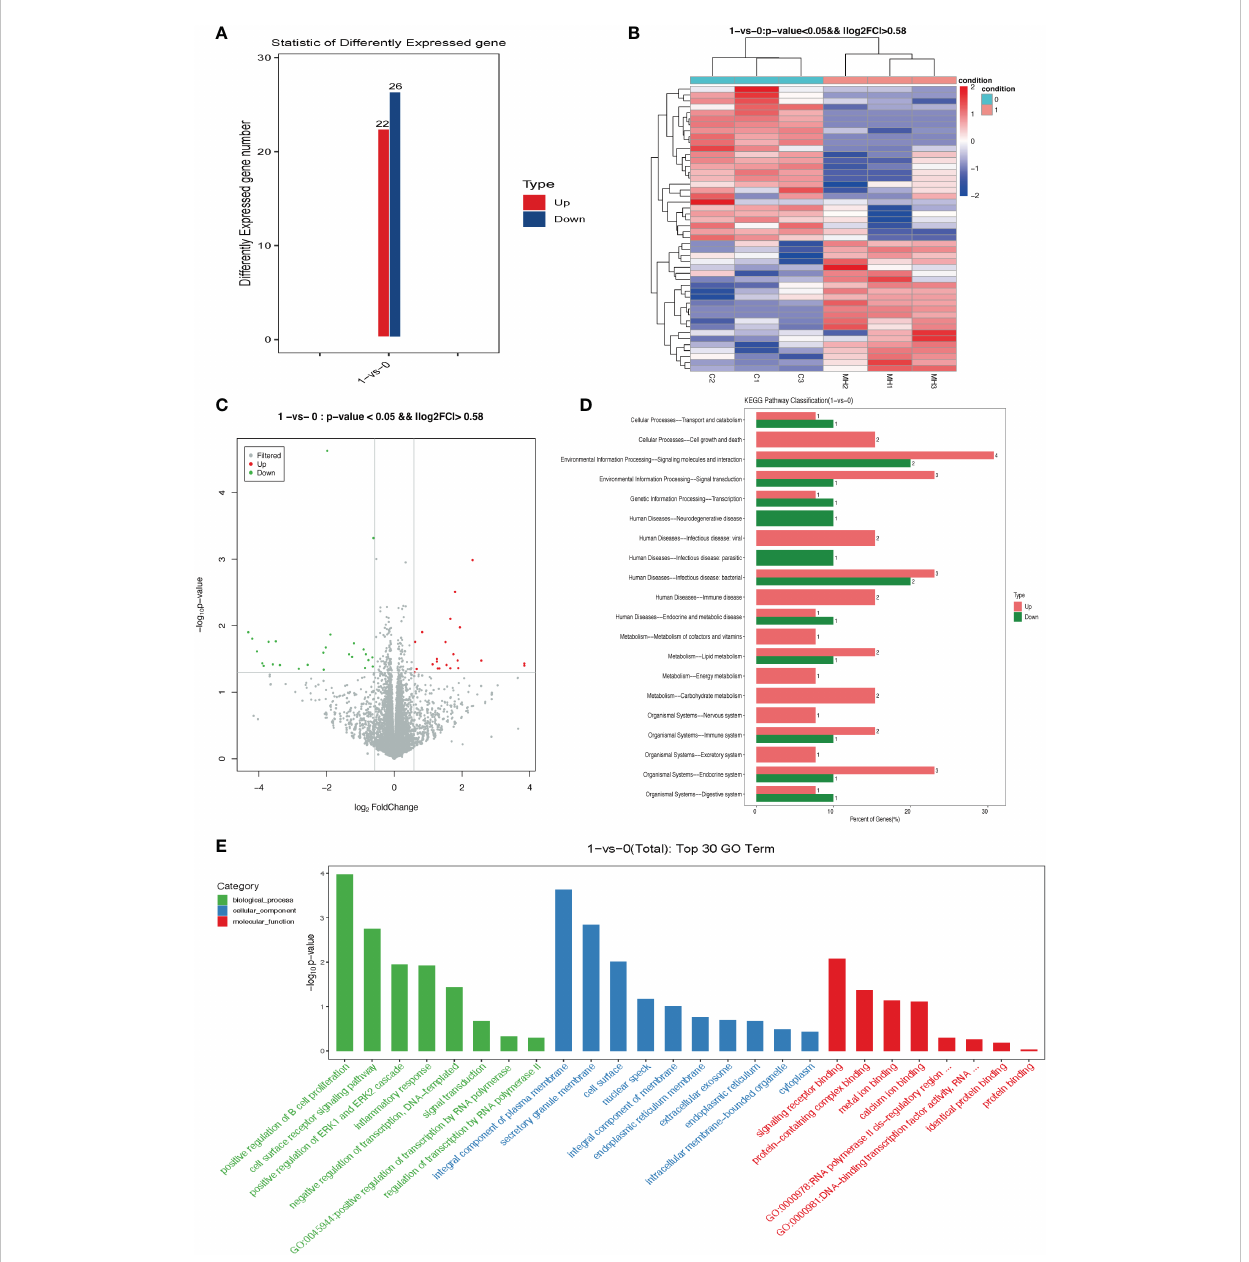
FIGURE 5 Differentially expressed genes (DEGs) in KGN cells treated with high dose insulin. (A) Column graph of DEGs in different treatment groups showing both up-regulated and down-regulated genes. (B) Heatmap. Green indicates repressed mRNA levels and red indicates elevated levels after insulin treatment. (log2 fold ratio ≥ 0.58; P < 0.01). (C) The volcano plot of DEGs present, in which green dots indicate down-regulated genes and red dots indicate up-regulated genes in response to insulin treatment. (D) KEGG enrichment analysis of differentially expressed genes. (E) GO terms of the top 30 enriched genes. The GO enrichment analysis grouped these differently expressed genes into functional groups. The green column represents biological processes, the blue column represents cellular components, and the red column represents molecular components. GO, Gene